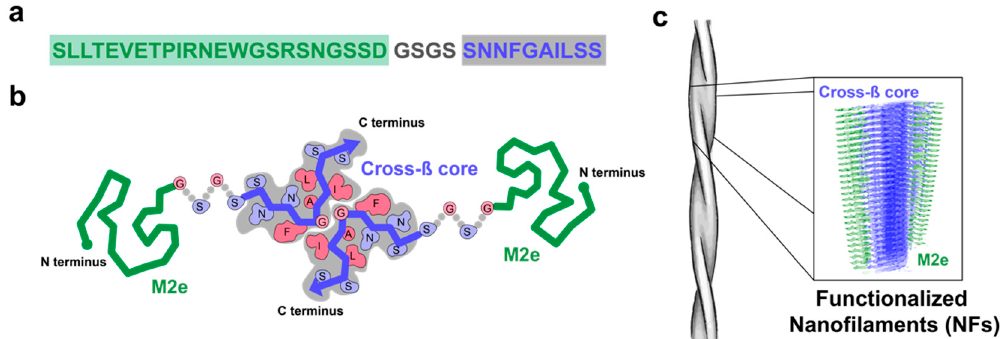
Figure 1. Schematic representation of cross- β fibrils decorated with the 23-mer negatively charged epitope (M2e) epitope. ( a ) Sequence of the M2e-I 10 peptide comprising the epitope derived from the N-terminal domain of M2 protein of the influenza virus (green), a short flexible tetrapeptide linker (gray), and the self-assembling peptide I 10 (in blue). Please note that the Cys residues at positions 17 and 19 were substituted to Ser to avoid undesired oxidation and/or formation of aberrant disulfide bonds, without affecting immunogenicity of M2e and affinity/selectivity of the resulting antibodies [29]. ( b ) Schema of two M2e-I 10 peptides interacting via a cross- β motif. ( c ) Representation of fibrils and arrangement of the cross- β supramolecular structure with the M2e epitope exposed on the surface.